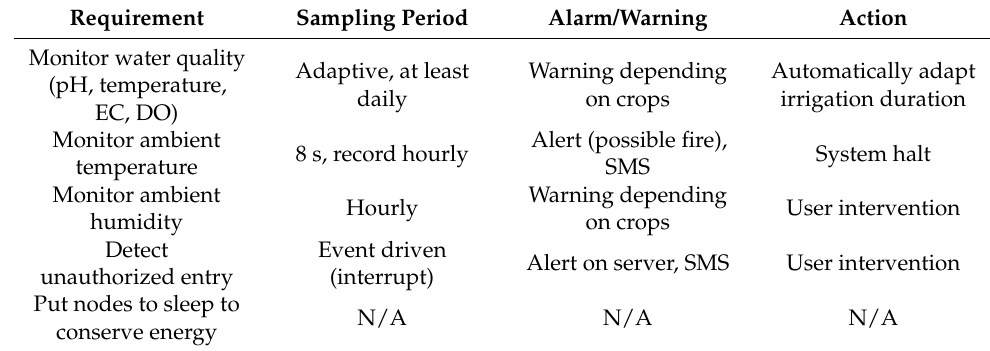
Table 2. iPONICS system